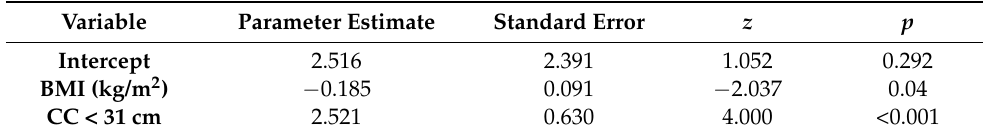
Table 5. Statistical results of the forward stepwise regression prediction model (Model 1) for sarcopenia.